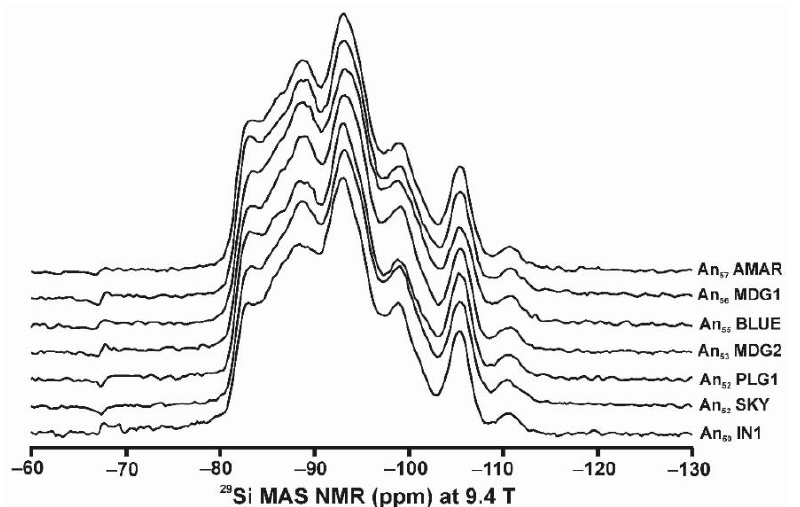
Figure 16. The 29 Si MAS NMR spectra at 9.4 T in several specimens of labradorite between An 50 and An 57 . The 29 Si spectra were recorded at υ r = 14.3 kHz in a 4 mm rotor, using a 0.5 μs excitation pulse, and a recycle delay of 0.75 s.